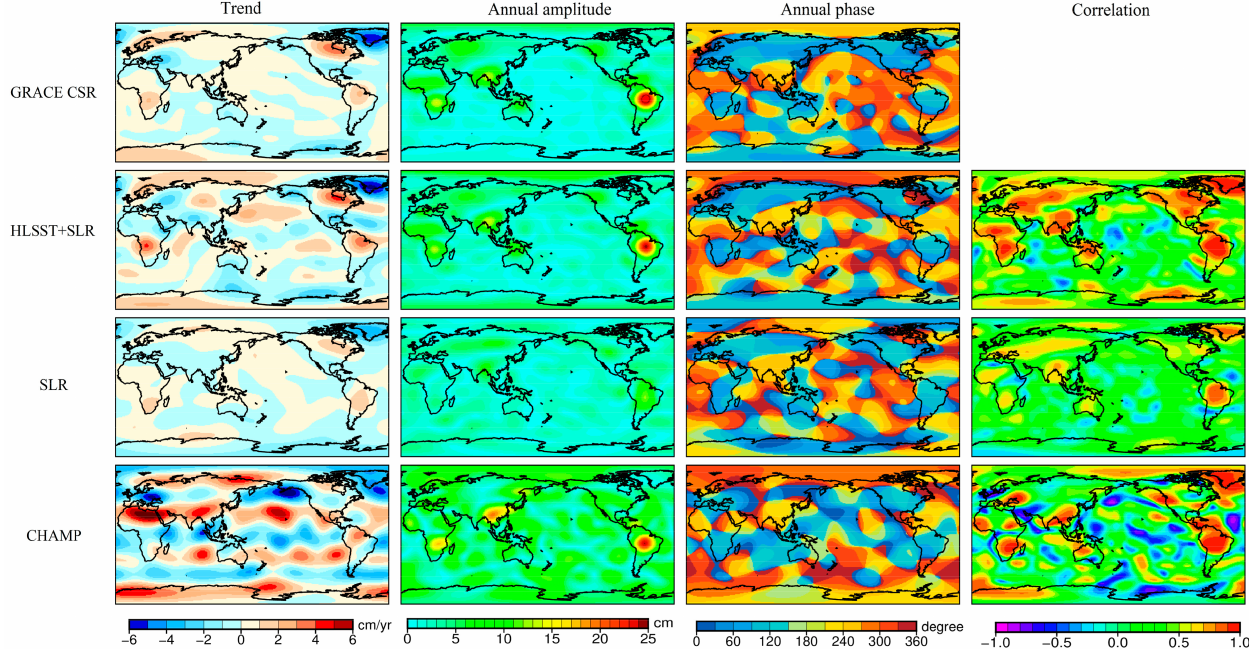
Figure 6. Trend, annual amplitude, and phase fitted from mass variations derived from GRACE CSR monthly ( first row ), HLSST+SLR monthly ( second row ), SLR monthly ( third row ), and CHAMP monthly ( fourth row ) solutions in terms of centimeters of water height equivalent. Spatial correlations of mass changes from each kind of solution with the standard GRACE CSR solutions are in the fourth column. The maps are based on monthly solutions covering the 11-year period from January 2003 to December 2013, with coefficients of all solutions truncated to degree